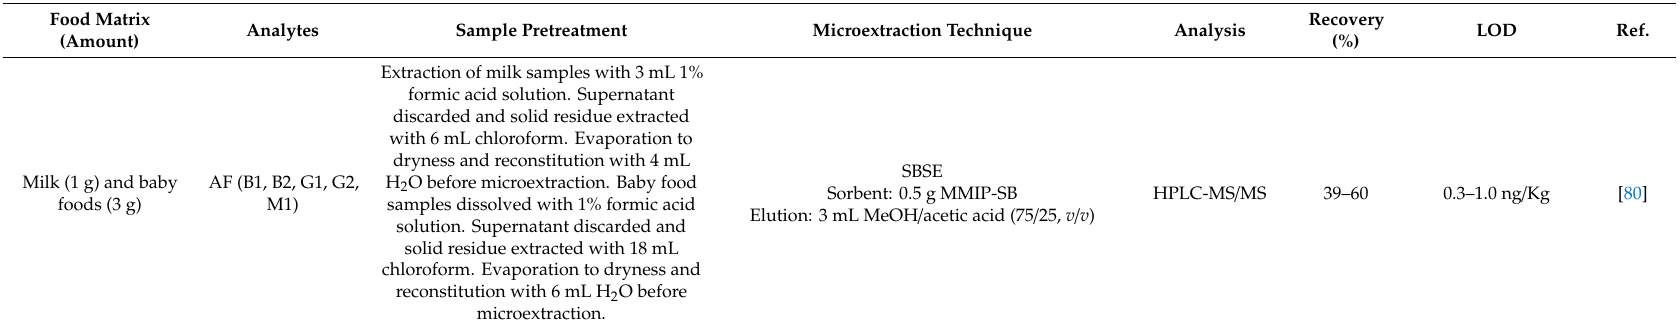
reconstitution with 6 mL H 2 O before